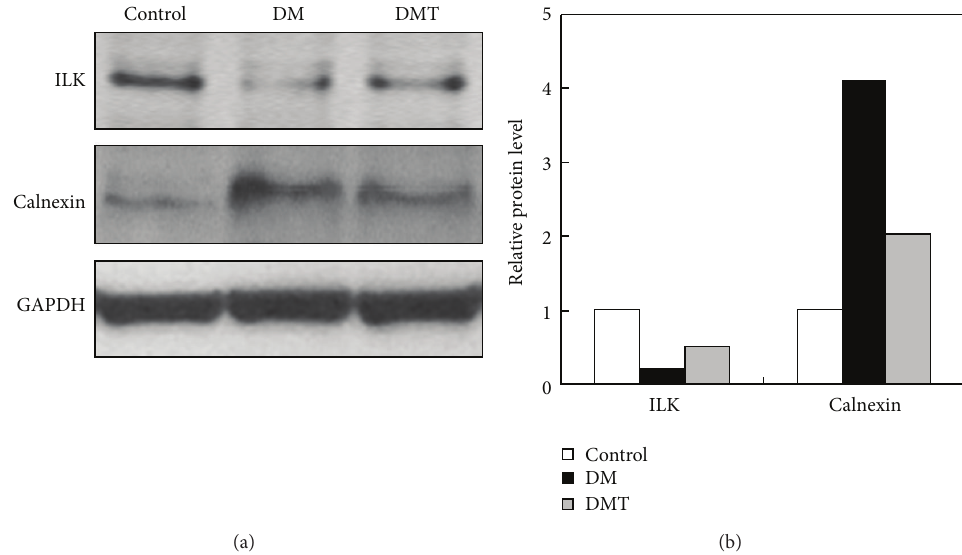
Figure 7: (a) Western blot validation of the differentially expressed proteins integrin-linked protein kinase (Ilk) and Calnexin. (b) Quantification of band intensity using VisionWorks LS image acquisition and analysis